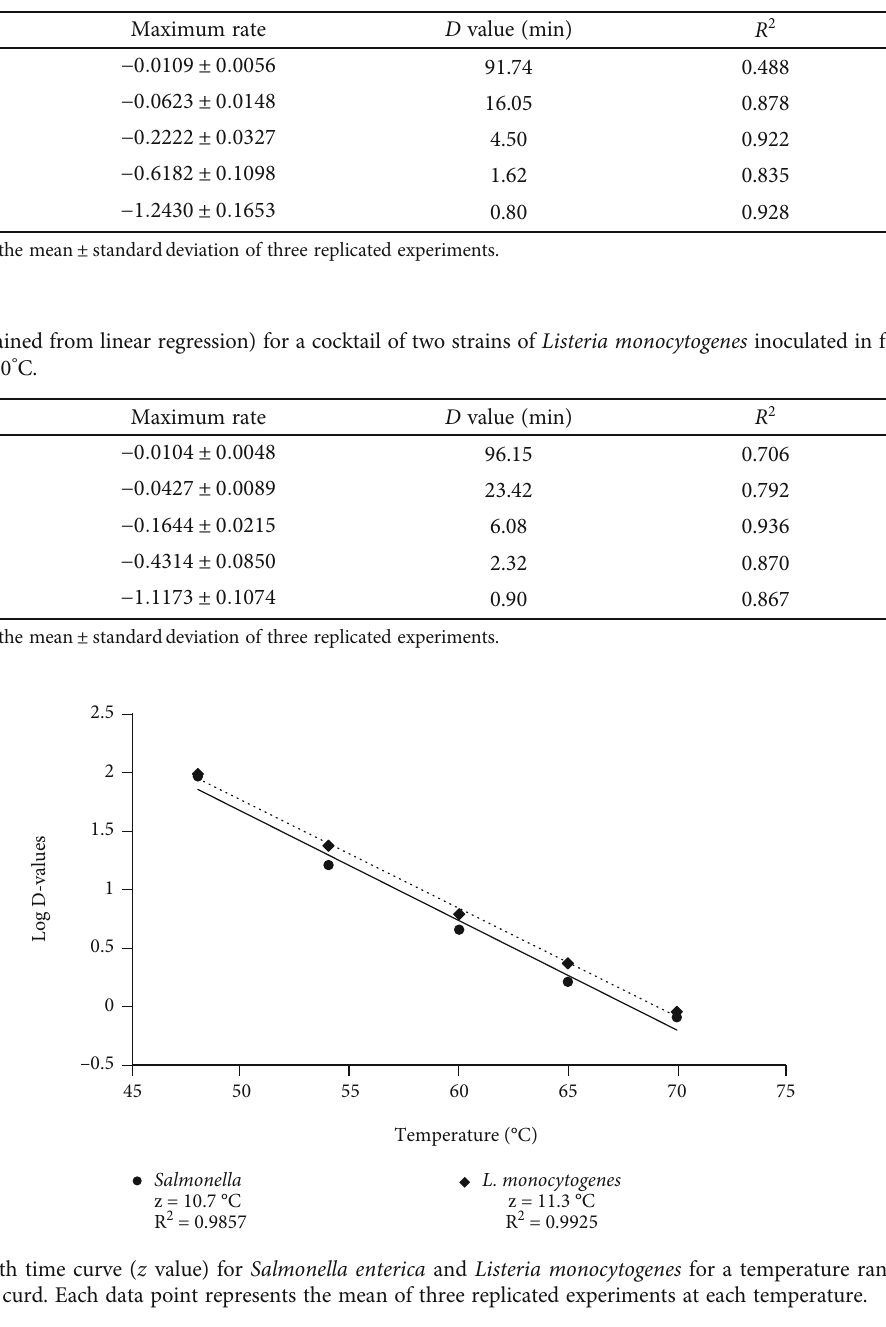
Table 2: D values (obtained from linear regression) for a cocktail of two strains of Salmonella enterica inoculated in fresh curd during quesillo making at 48-70 ° C.